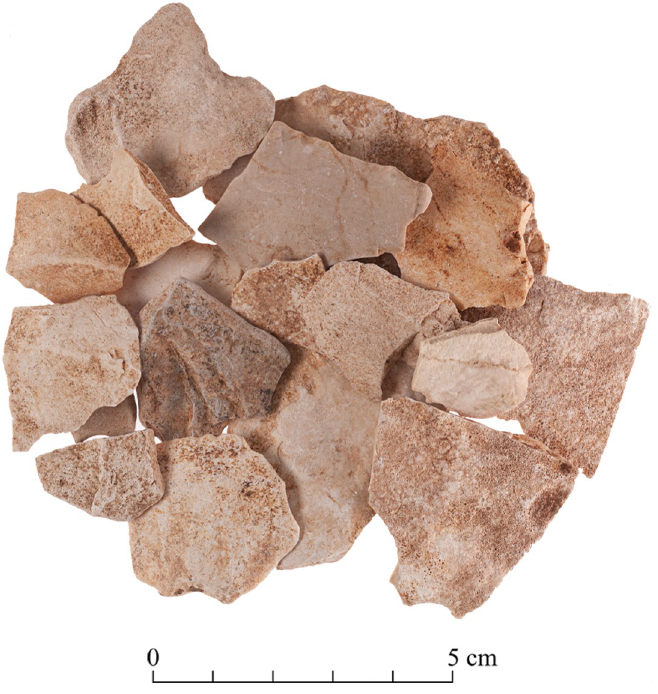
Fig 40. Limestone thinning